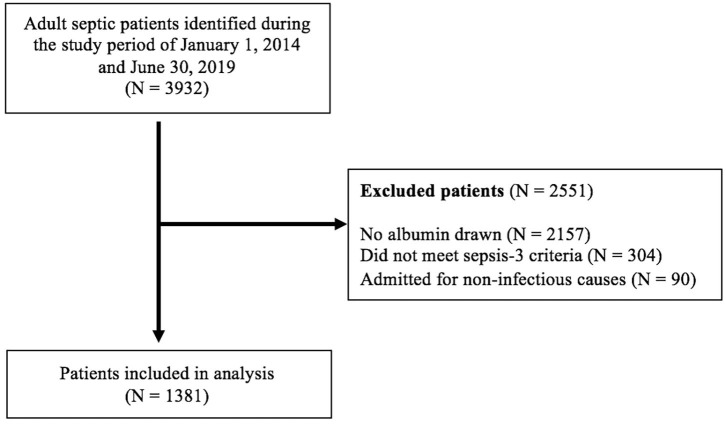
Flow diagram of patient selection.